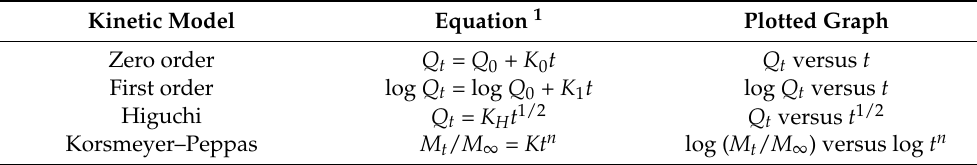
Table 2. Kinetic models used in the evaluation of the RIF release mechanism from the Mt–RIF nanohybrid